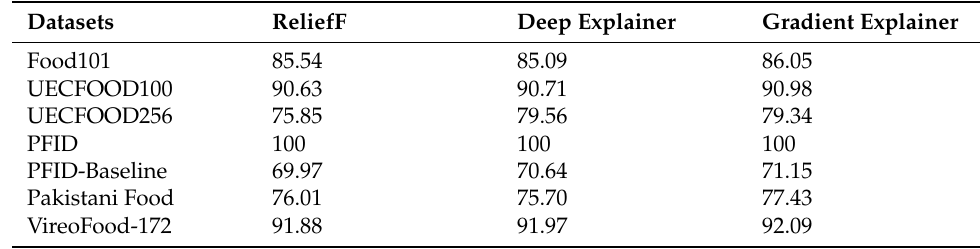
Figure 17. Red pixel shows the SHAP values that increase the probability of the ingredients. The blue pixels show the SHAP values that decreases the probability of the ingredients. By us- ing ranked_outputs = 5 we explain only the five most likely ingredients. Table 4. Comparison of average classification performance on incrementally trained classifier PKELM (RBF) by using different feature selection